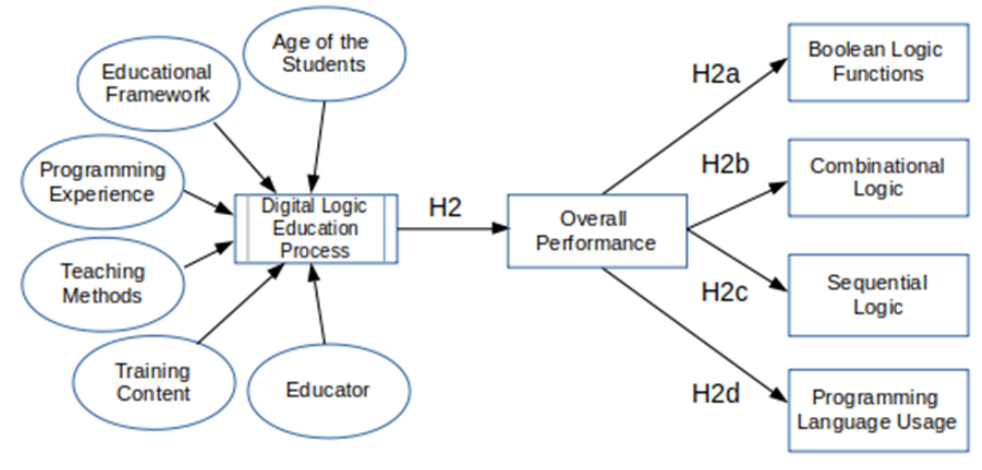
Figure 4. Variables influencing the training and relation to